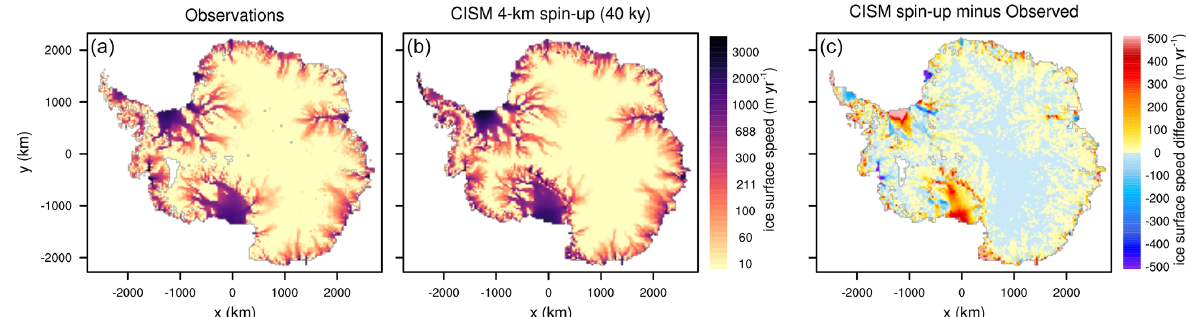
Figure 2. Observed (a) (Rignot et al., 2011) and modeled (b) Antarctic surface speed (m/yr, log scale) at the end of spin-up. Panel (c) shows the difference between modeled and observed surface speeds (m/yr). White patches represent missing